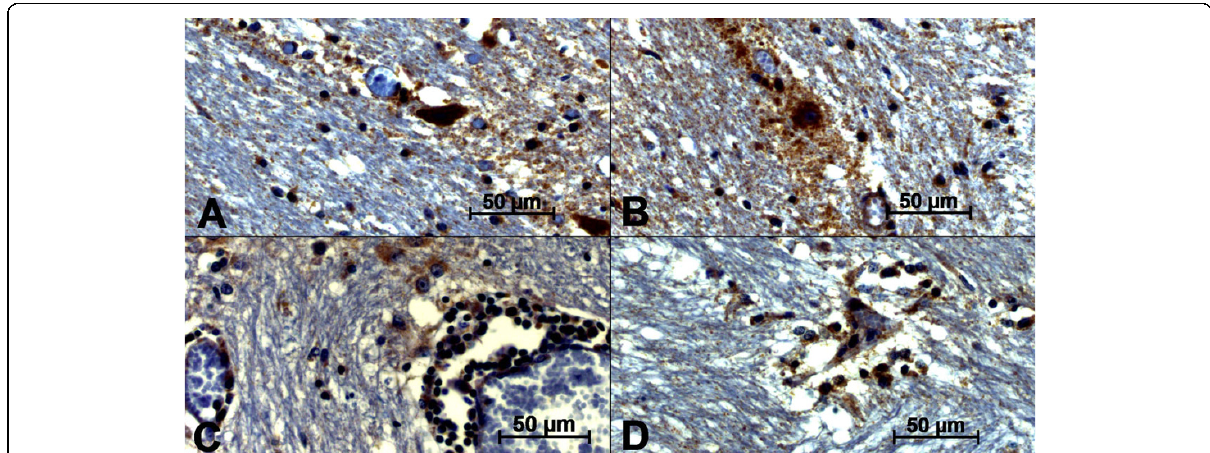
Figure 3 Photomicrography of AOP-1 antigen detection by immunohistochemistry in the frontal cortex of BoHV-5-infected calves (A- D) . A) area of intense immunoreactions in the parenchyma; B) intense positive signals surrounding neuron as well as the area of neuron; C) inflammatory cuffs showing intense positive reaction close to mononuclear cells; D) positive labeling associated with gliosis and satellitosis. The strepavidin-biotin peroxidase complex method was used. (scale bar 50 μ m)